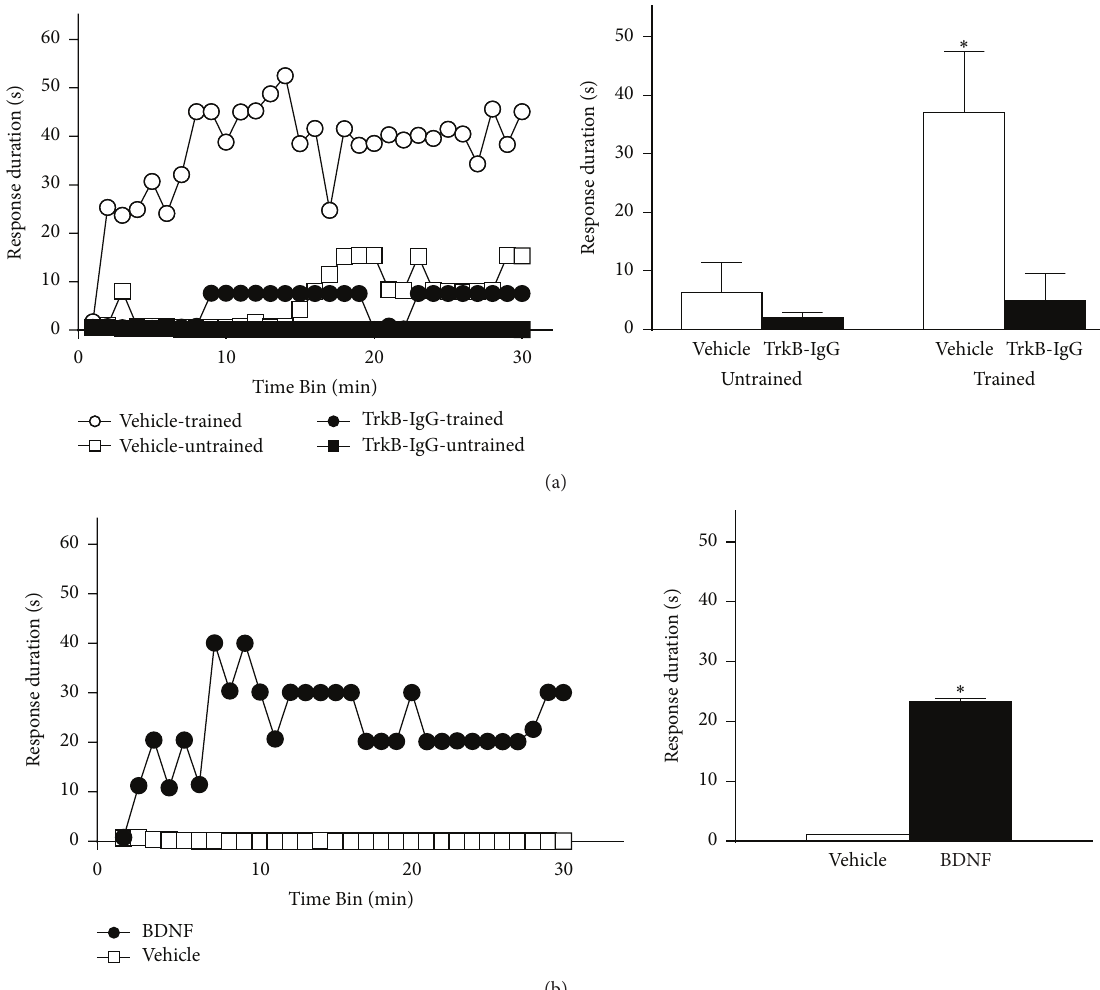
Figure 4: Role of BDNF in the protective effect of spinal instrumental training. (a) The necessity for endogenous BDNF in the spinal training effect. Rats received an intrathecal injection of either vehicle (saline) or the BDNF inhibitor TrkB-IgG and then either spinal instrumental training (trained) or none (untrained), followed by 6min of uncontrollable shock. All subjects were then tested for instrumental learning over 30 minutes. Vehicle-treated subjects that were not trained prior to uncontrollable shock (vehicle-untrained) exhibited a learning deficit, whereas those prior training protected against this deficit (vehicle-trained). Subjects that received TrkB-IgG exhibited a learning deficit, regardless of training, indicating a necessary role for endogenous BDNF in the protective effect of spinal training. (b) To test the sufficiency for BDNF in the protective effect against uncontrollable shock, either vehicle or intrathecal BDNF was delivered prior to 6 minutes of uncontrollable shock. Rats that received vehicle prior to uncontrollable shock exhibited a deficit when tested for instrumental learning. Those treated with BDNF prior to uncontrollable shock were able to learn, indicating that BDNF is sufficient to protect against the maladaptive effects of uncontrollable shock ( ∗ 𝑝 < 0.05 ). Error bars indicate SEM. Adapted from Huie et al.